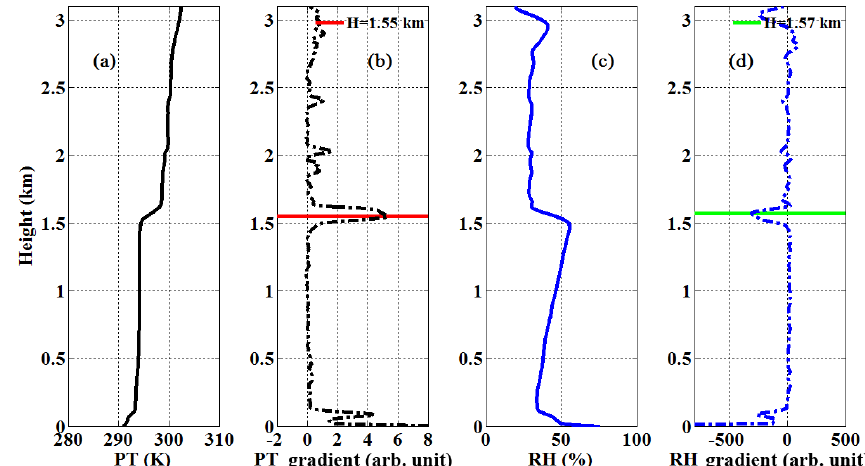
Figure 10. Radiosonde profiles of (a) potential temperature (K), (b) the gradient of potential temperature, (c) relative humidity (%), and (d) the gradient of relative humidity at 12:00,LT on 14 May 2014. The horizontal red and green lines in (b) and (c) stand for MABL height retrieved from potential temperature and relative humidity, respectively.